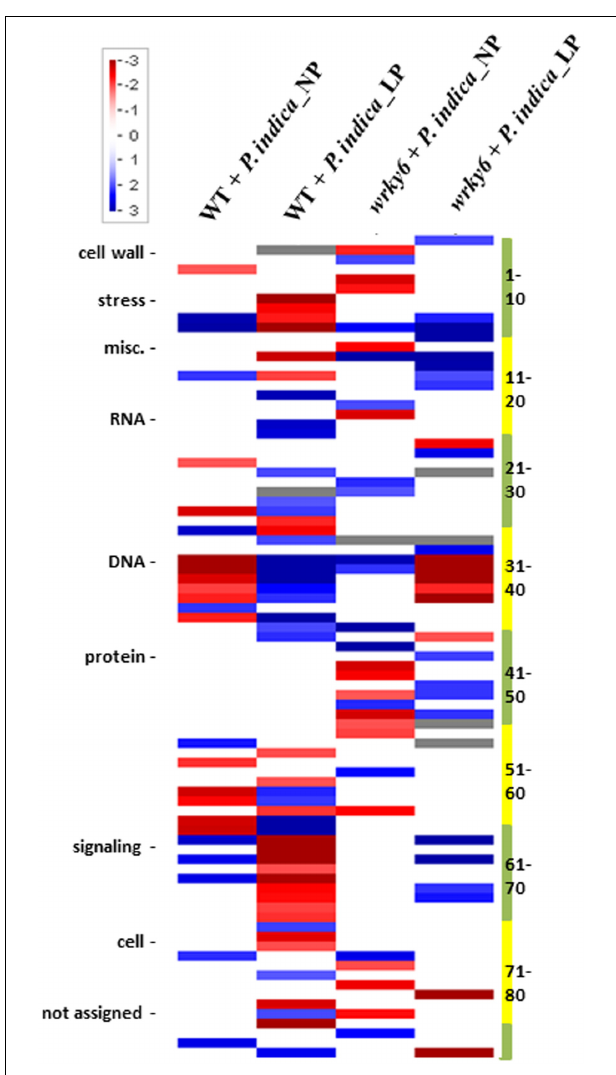
FIGURE 2 | PageMan analysis of differentially expressed genes ( > 2-fold) by P. indica in WT or wrky6 roots grown on either NP or LP. Scale depicts level of expression with blue being high and red being low. Only significantly regulated ( p -value < 0.05) categories are shown. Numbers on the right refer to the categories defined by the PageMan program, which are presented in Supplementary Table S1. For specific genes, see data submitted to NCBI. For more detailed information on the program, cf. the MapMan software at http://mapman.gabipd.org/web/guest/